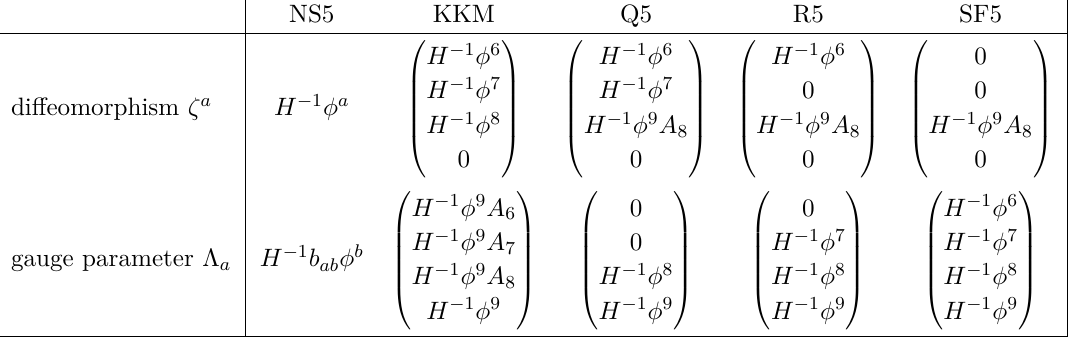
Table 4 . The diffeomorphism and the B -field gauge parameters in each T-duality